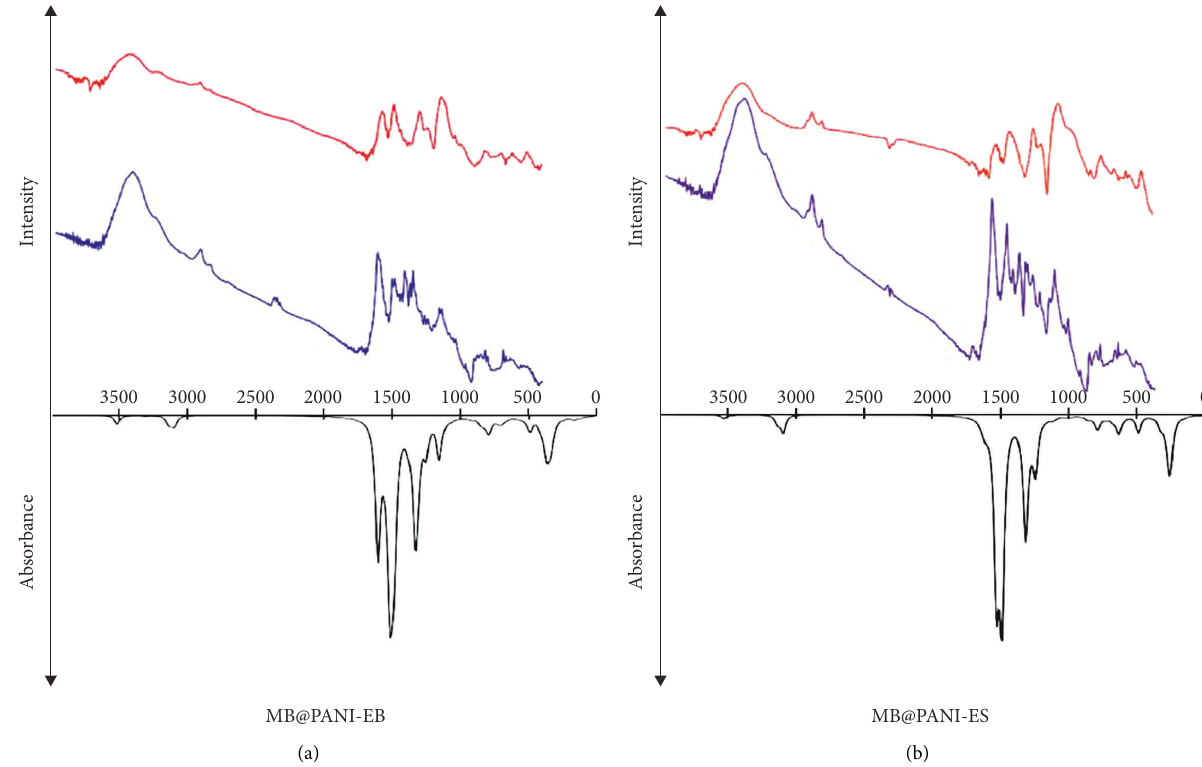
Figure 4: Experimental FTIR spectra of PANI (red) and MB@PANI systems (blue) and their comparison with DFT computed IR spectra (black) of MB@PANI. Samples: (a) PANI-EB (base-treated) and (b) PANI-ES